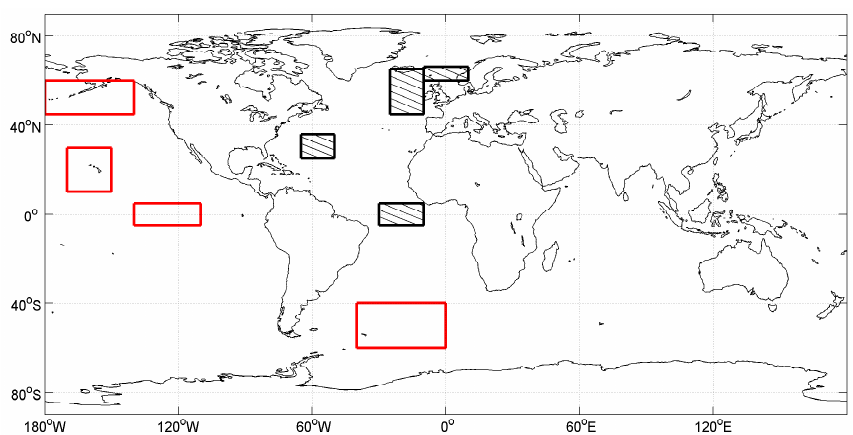
Fig. 1. Location of the areas used for both confirmatory and exploratory analysis (black) and only exploratory analysis (red). Black boxes correspond to the NorwSea, NEAtl, WCAtl and EqAtl when looking from north to south. Red boxes correspond to the NEPac, CPac, EEP and AntAtl when looking from north to